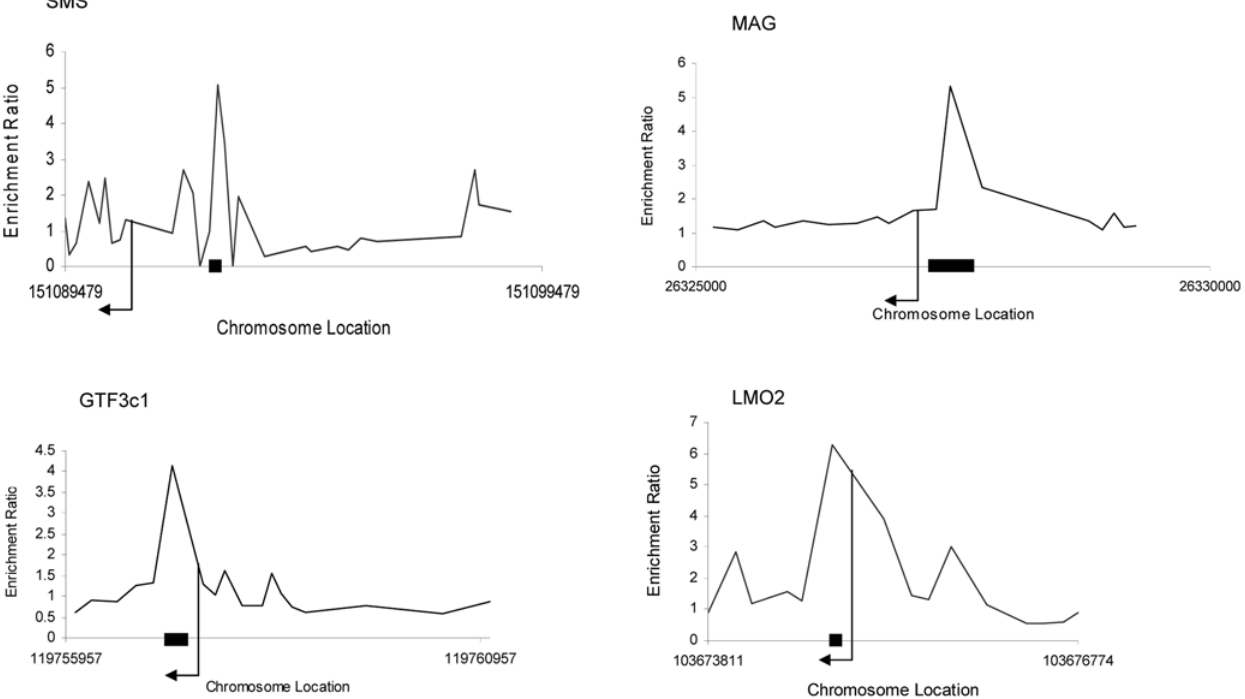
Figure 3. Examples of TR b binding activities identified with ChIP-on-chip. The plots show enrichment ratios for all probes within a genomic region (IP versus TI DNA). Chromosomal positions are from NCBI build 34 of the mouse genome. The start and direction of transcription are noted by arrows. Black bars on the X axis indicate the fragments whose enrichment was confirmed with PCR.